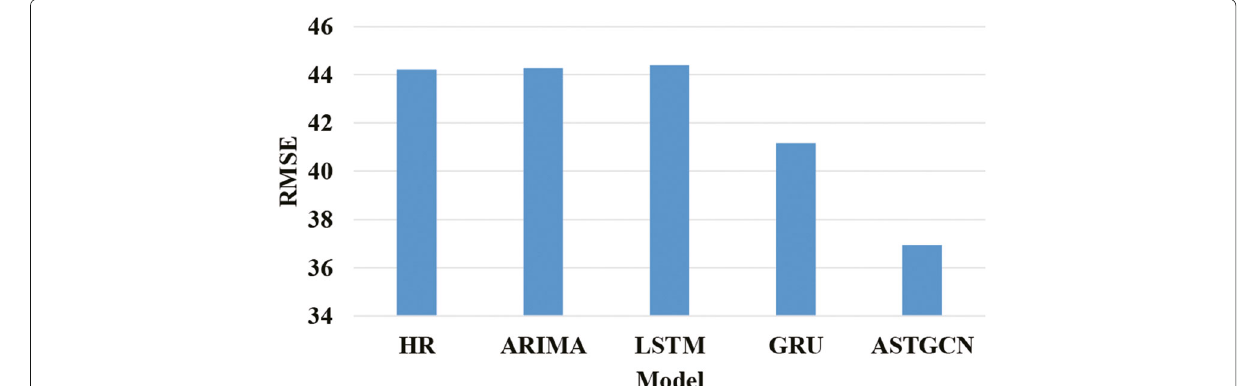
Fig. 4 RMSE of HA , ARIMA , LSTM , GRU and ASTGCN